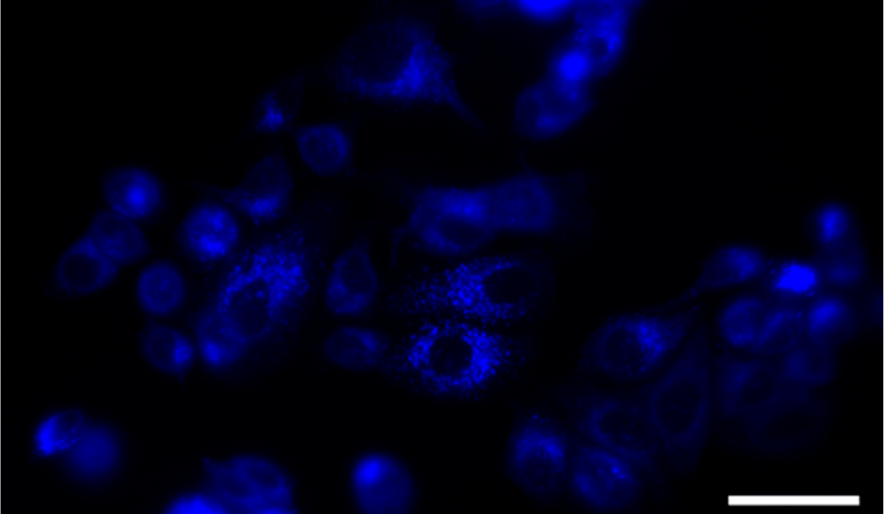
Figure 3. Fluorescent microscopy image of MCF-7 incubated with 10 µM concentration of com- pound 12b . The cells were treated for 30 min, rinsed, and analyzed by fluorescent microscope at 400 × magnification. Compound 12b shows predominantly cytoplasmic distribution. The scale bar is 50 µm.